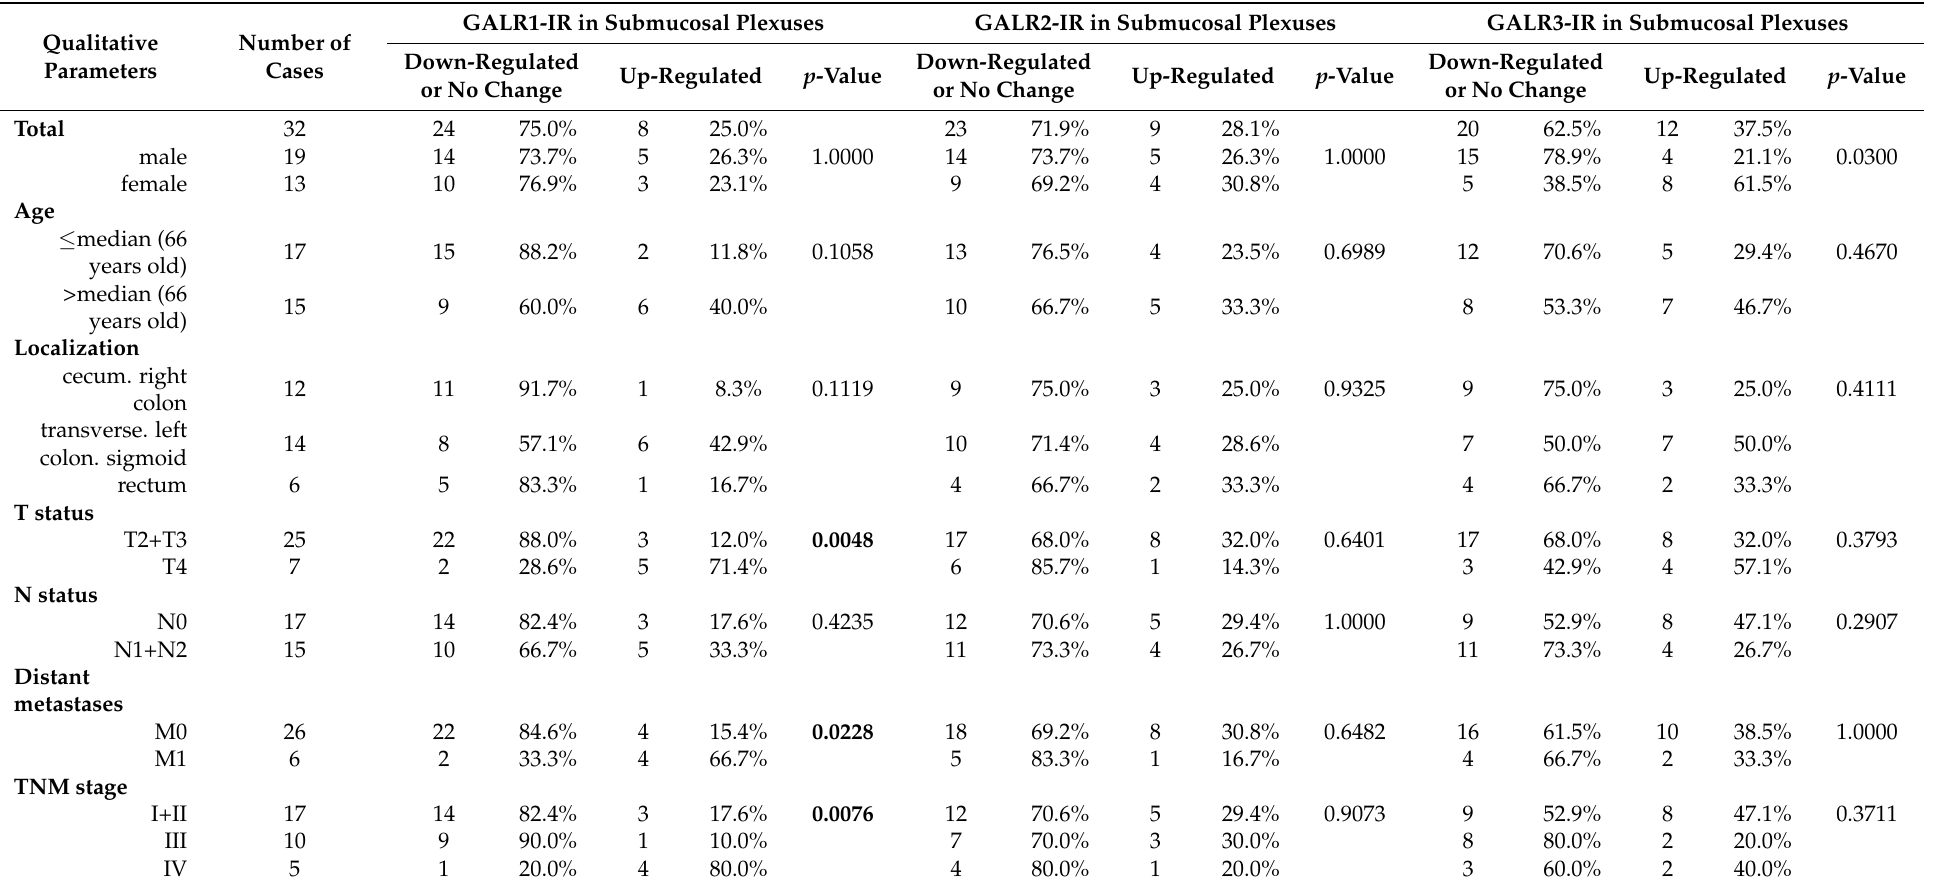
Table 4. Association between demographic and clinico-pathological features of colorectal (CRC) patients (n = 32) and relative expression levels of galanin receptors in submucosal plexuses determined by